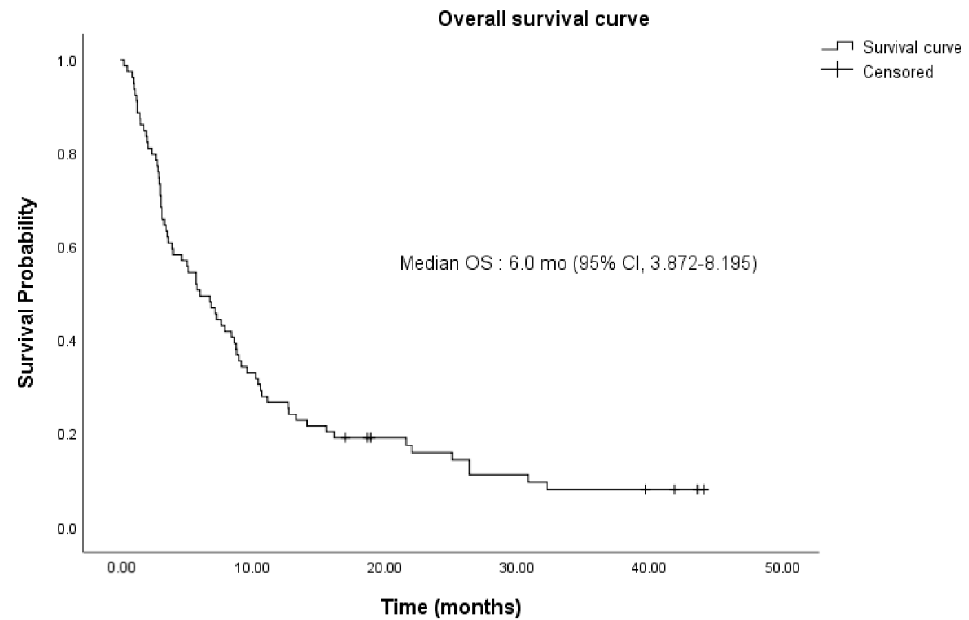
Figure 2. Kaplan–Meier estimates of the overall survival (OS) of the entire study population (n = 80). Median OS was 6.0 (95% confidence interval (CI), 3.872–8.195) months. OS, overall survival; mo, month; CI, confidence interval.